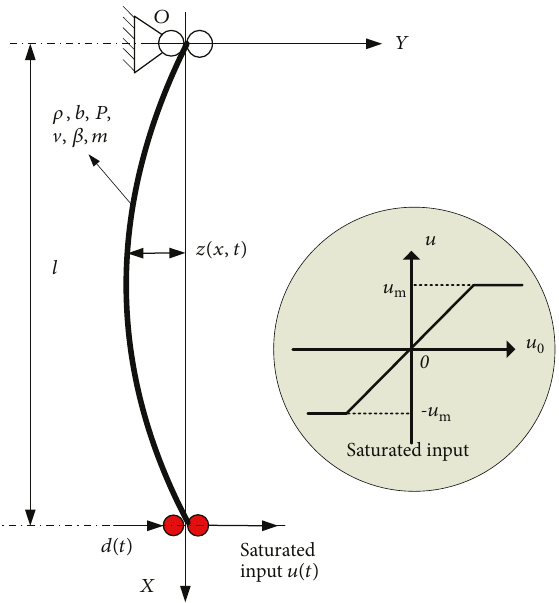
Figure 1: An axially moving string system with saturated